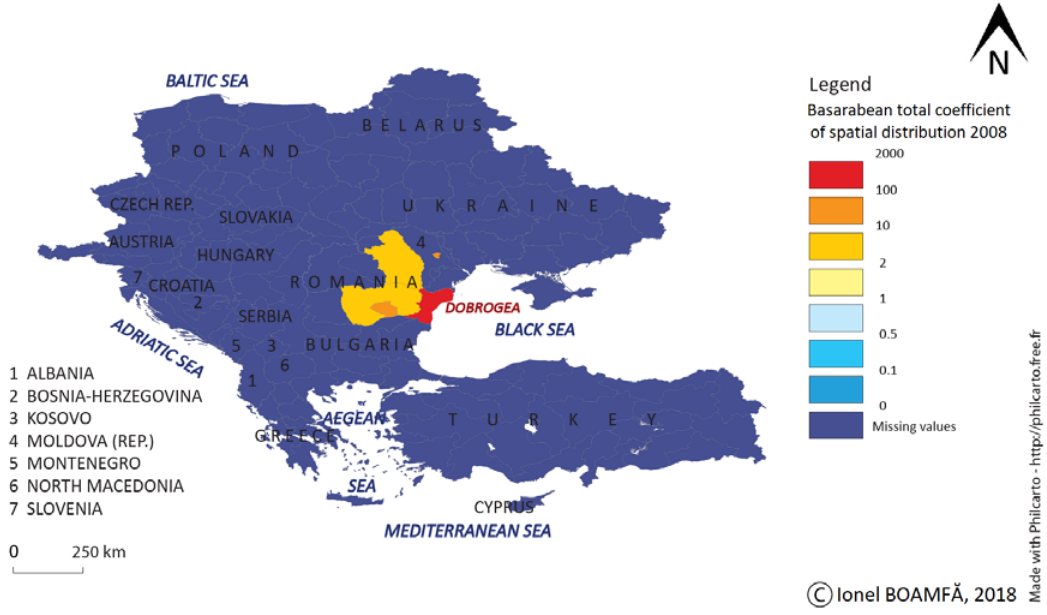
Figur e 4 . G eographical repartition of the anthroponym Basarabean. Coef. of spatial